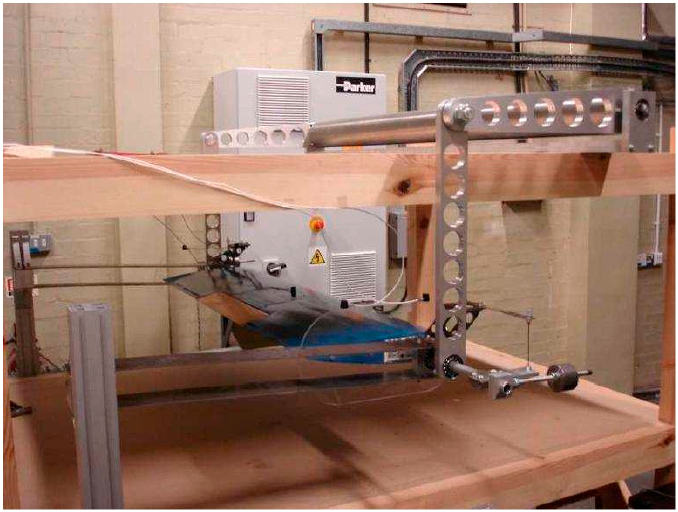
Figure 4. Experimental test rig of the typical wing section [22].